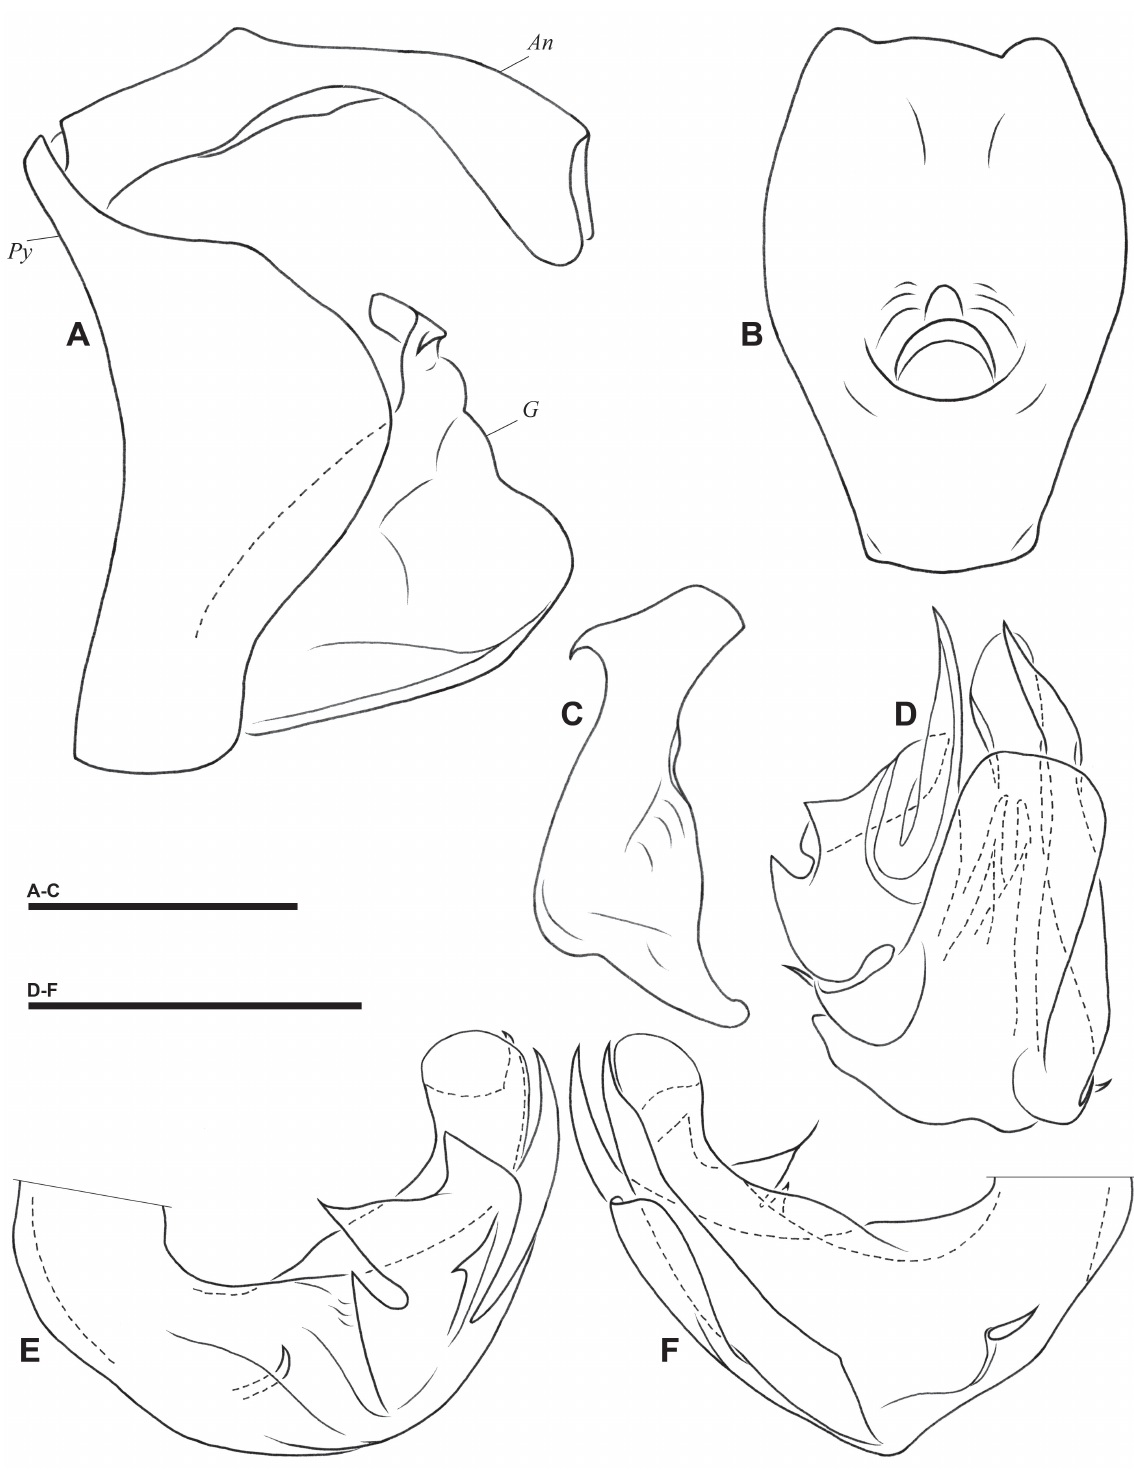
Fig. 4. Gergithus (Maculergithus) luteomaculatus subgen. et sp. nov., holotype, male genitalia. A . Pygofer, anal tube and gonostyli, left lateral view. B . Anal tube, dorsal view. C . Left gonostylus, posterior view. D . Aedeagus, postero-ventral view. E . Aedeagus, left lateral view. F . Aedeagus, right lateral view. Abbreviations: An = anal tube; G = gonostyli; Py = pygofer. Scale bars: 1